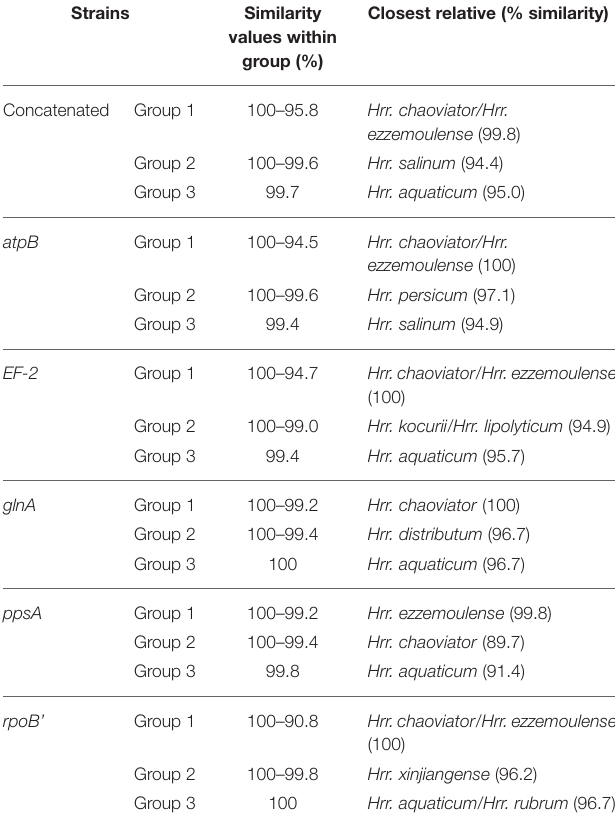
TABLE 1 | Similarity values for strains within groups 1, 2, and 3 based on the concatenated and individual housekeeping gene sequence and their most closely related taxa with validly published names.